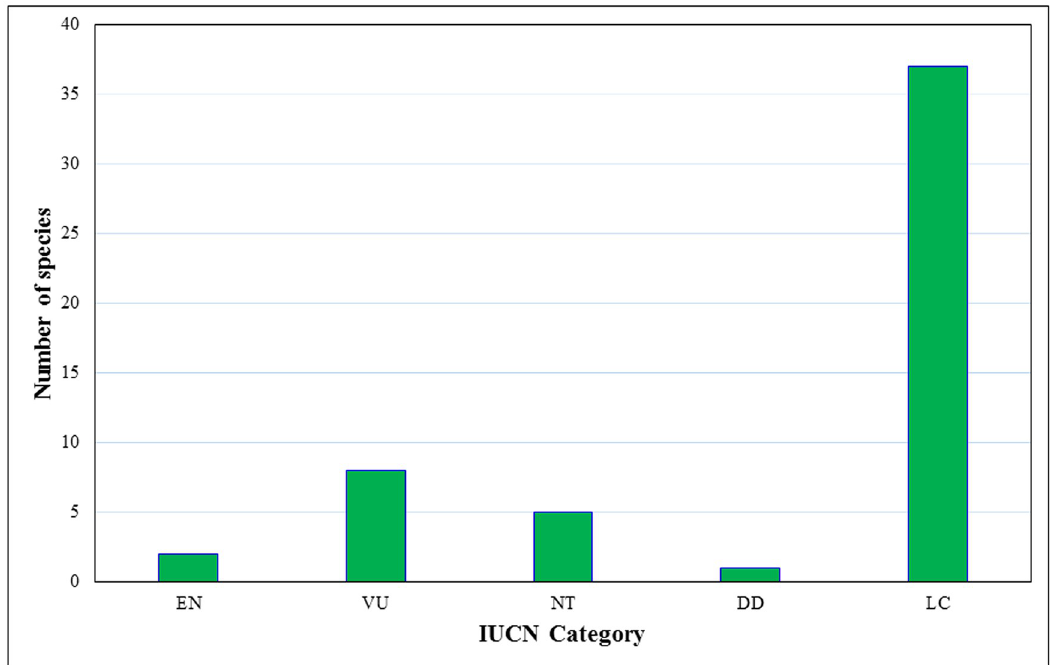
Fig 8. Conservation status of wild vertebrate species used in ethnomedicine in the Chitwan-Annapurna Landscape, Nepal (according to IUCN Red List, 2019).